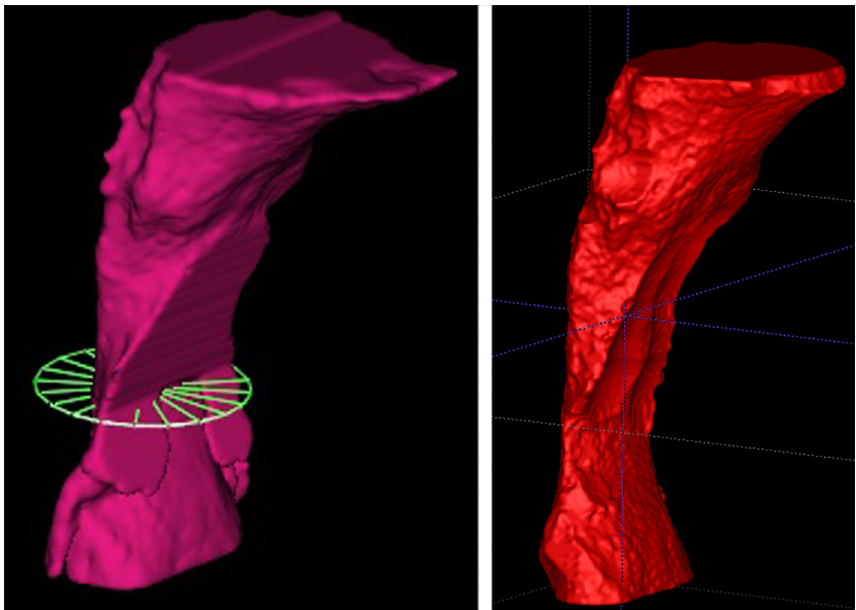
Figure 2- Segmentation of a single patient obtained with Dolphin3D (left) and with ITK-Snap (right)